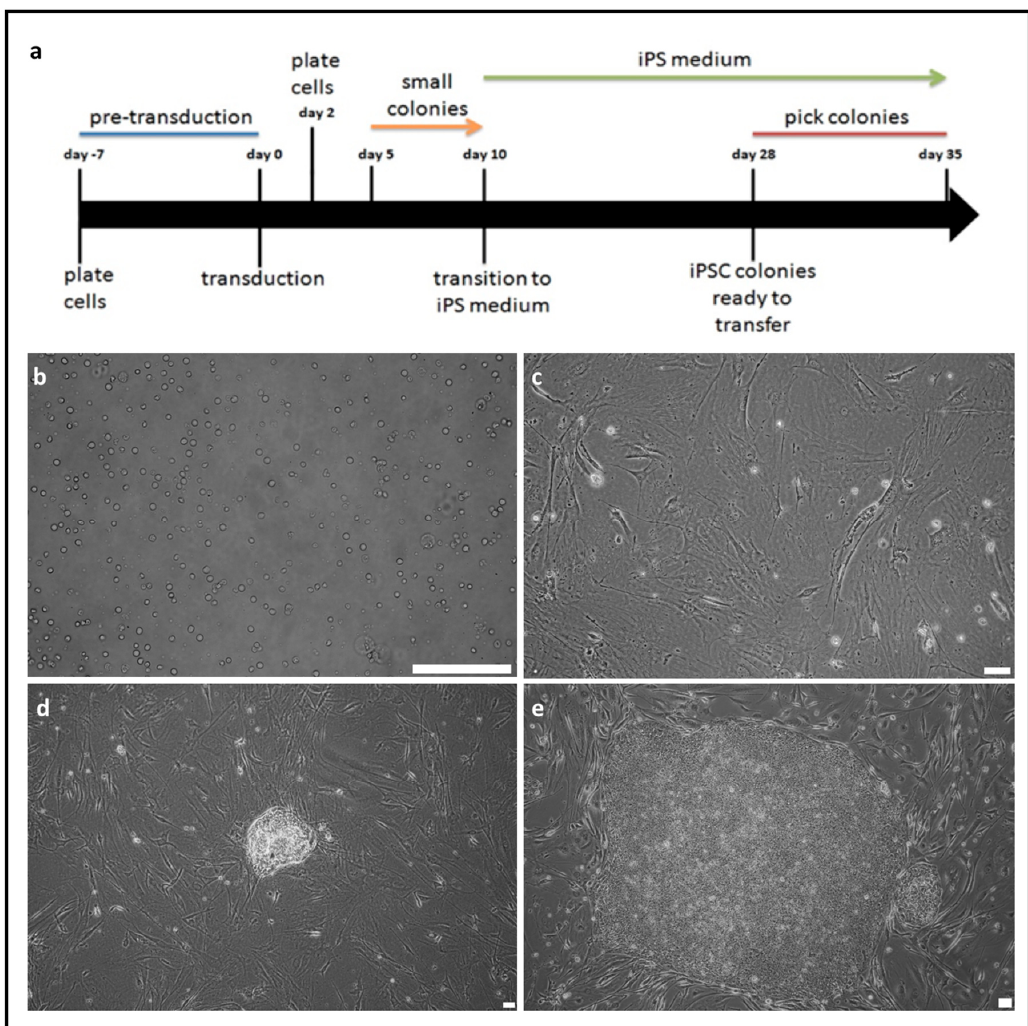
Figure 1. Scheme of induced pluripotent stem cells (iPSCs) generation from peripheral blood mononuclear cells (PBMCs) ( a ). ( b ) On day 0 PBMCs cells are transduced with Sendai viral vector. ( c )